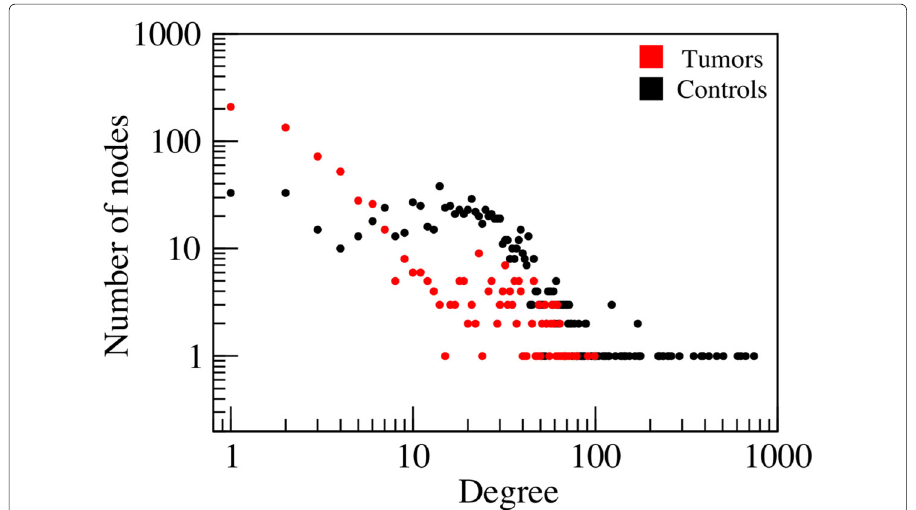
Fig. 6 Degree distributions for module networks of Fig. 5. Red dots represent the tumor network, meanwhile black dots are for